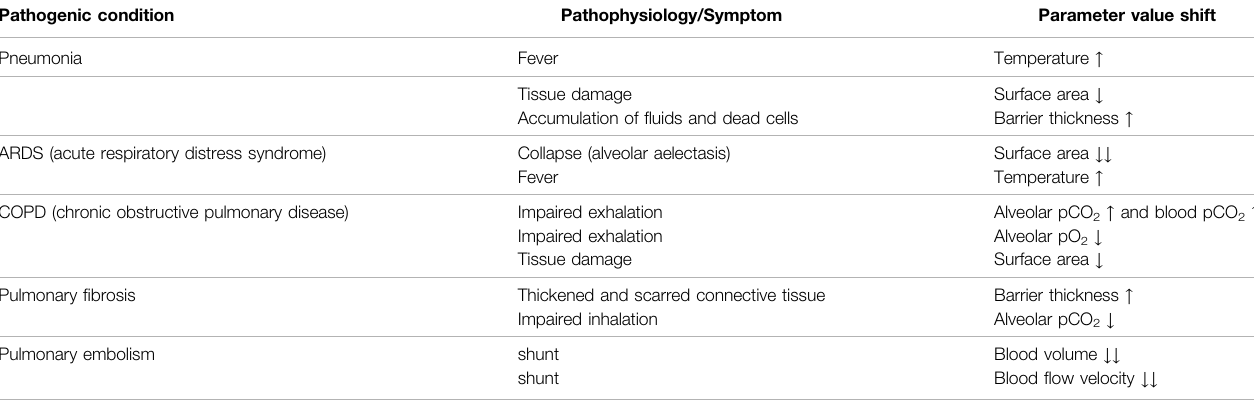
TABLE 2 | Parameter value shifts in presets representing pathogenic conditions. For every condition, pathophysiological issues or symptoms are represented by increased ( ↑ ) or decreased ( ↓ ) values of the respective model parameters. Pathogenic